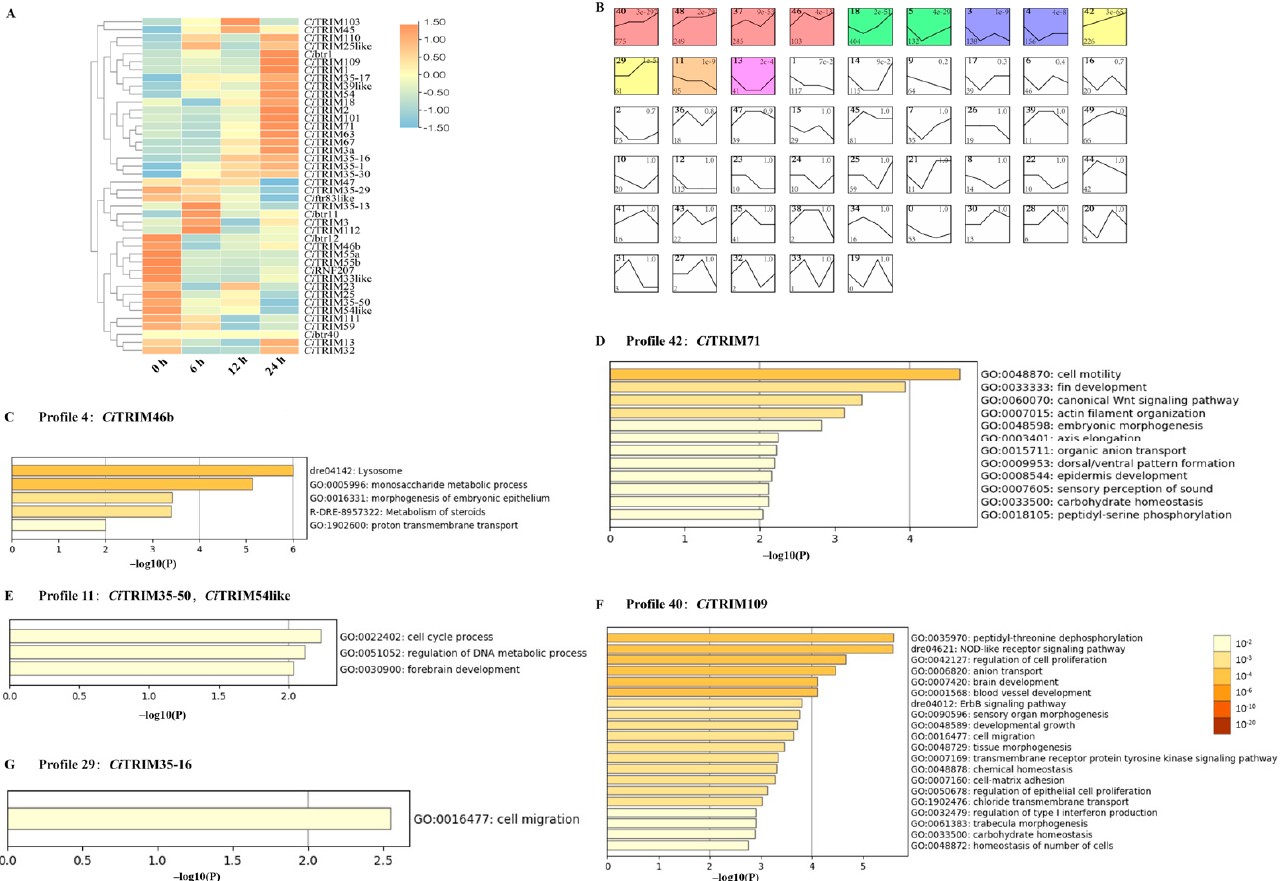
Figure 6. Transcriptome analyses of CIK after GCRV challenge. ( A ) Heatmap of 42 Ci TRIMs’ expression changes in CIK after GCRV infection at 0 h, 6 h, 12 h and 24 h. ( B ) Expression trend for genes in CIK transcriptomes during GCRV infection. A total of 50 profiles where the gene cluster exhibited a similar expression trend after GCRV challenge at 0 h, 6 h, 12 h and 24 h were produced using STEM. The data in the top-left corner, top-right corner and top-right corner represent the profile ID, the significance of cluster correlation and the number of genes in profiles, respectively. GO enrichment analysis for genes including differentially expressed Ci TRIMs in Profile 4 ( C ), Profile 42 ( D ), Profile 11 ( E ), Profile 40 ( F ) and Profile 29 ( G ). Coordinate ruler on the bottom (x-axis) of profiles represents the significance ( p -value) from GO enrichment analysis, which is shown as –log10(P).